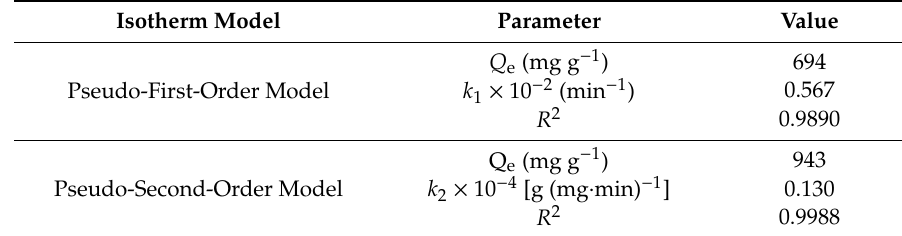
Table 2. Adsorption kinetics fitting results for MB on alginate sponge by pseudo-first-order and pseudo-second-order